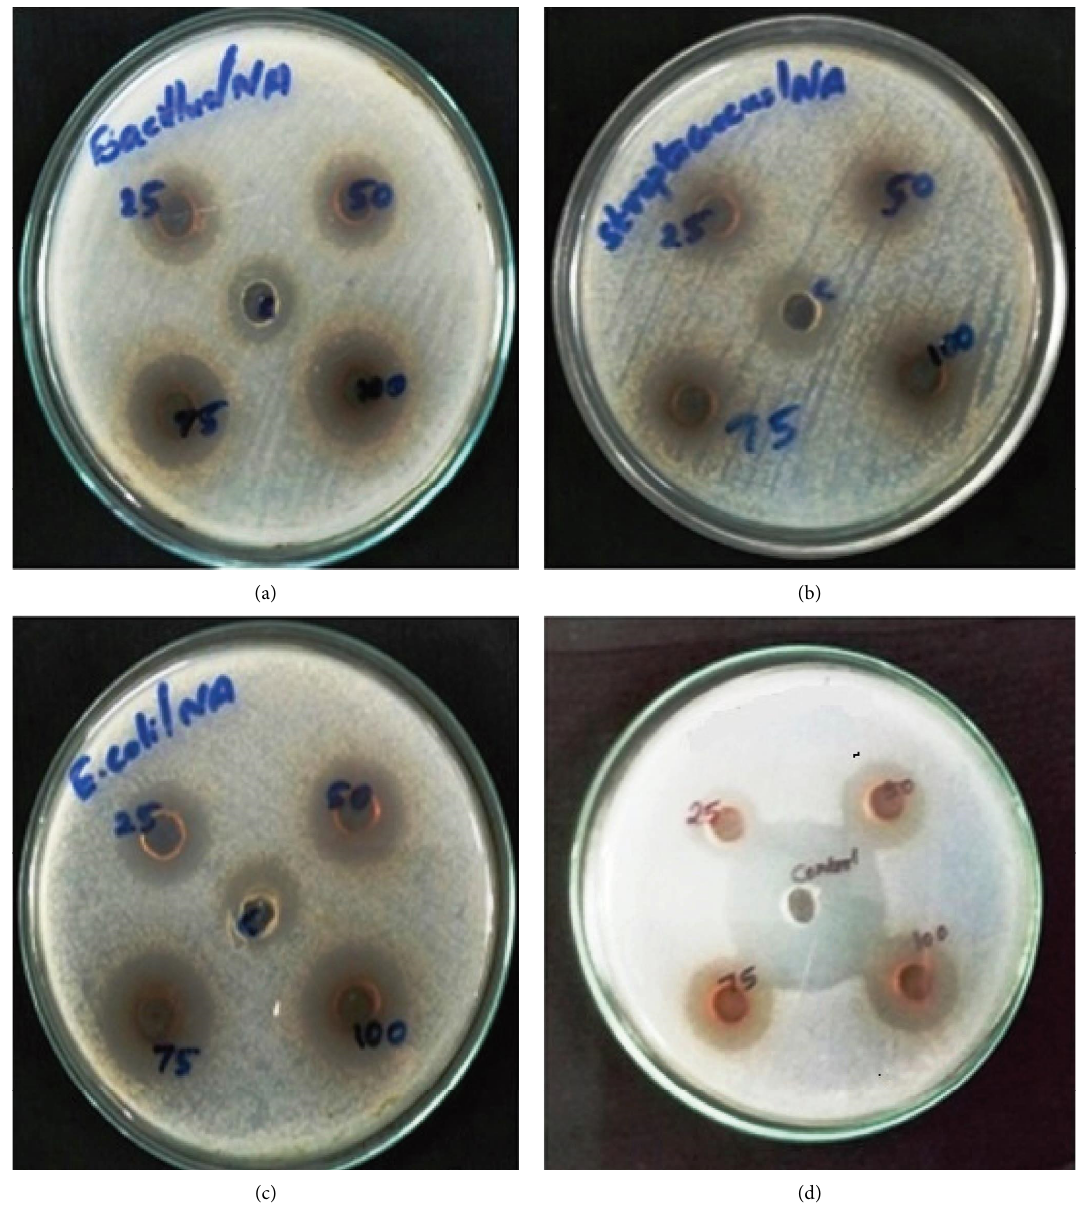
Figure 9: Antibacterial activity showing inhibition zone when treated by StAc-AgNPs against (a) M. luteus, (b) S. aureus, (c) E. coli , and (d) P.